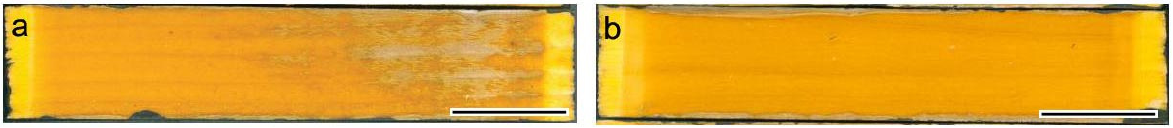
Figure 12. Effect of plasma treatment for 3 min on the performance on an oil-borne polyurethane coating on black spruce exposed to 2000 h of artificial accelerated weathering: ( a ) Untreated control; ( b ) Plasma treated. Scale bars = 15